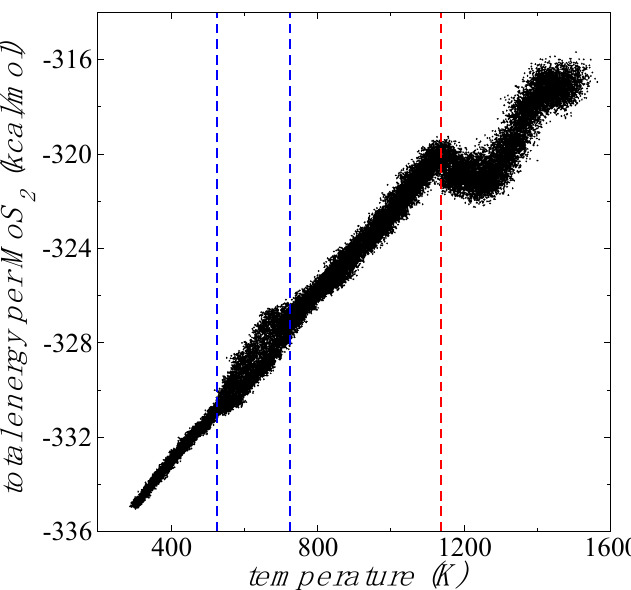
Figure 5. Scan of E #MoS2 of 1L Mo 243 S 486 flake (black points) as a function of the instant flake T, under vacuum and NVT conditions with T increased from 298.15 to 1500 K at a rate of 100 K/300 ps. The discontinuous blue delineates the region of high fluctuations between 525 and 725 K. The discontinuous red line delineates the region of linear dependency of E #MoS2 with the T.